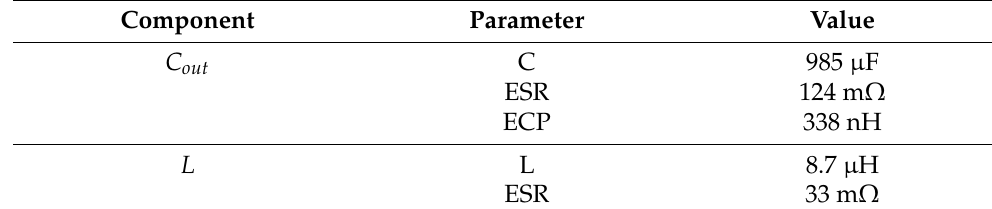
Table 1. The parameters of input capacitor C out and inductor L. Component Parameter